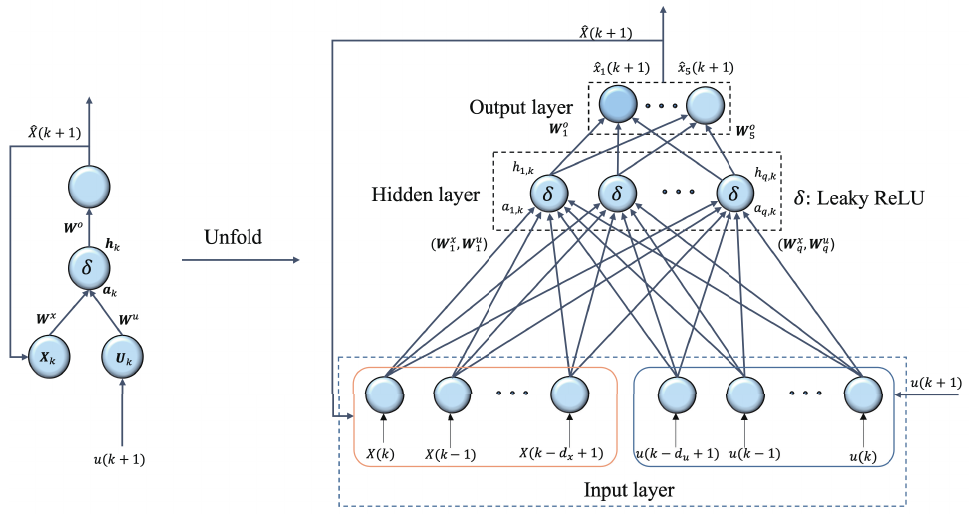
Figure 2. The ReLU-RNN architecture used to approximate system dynamic